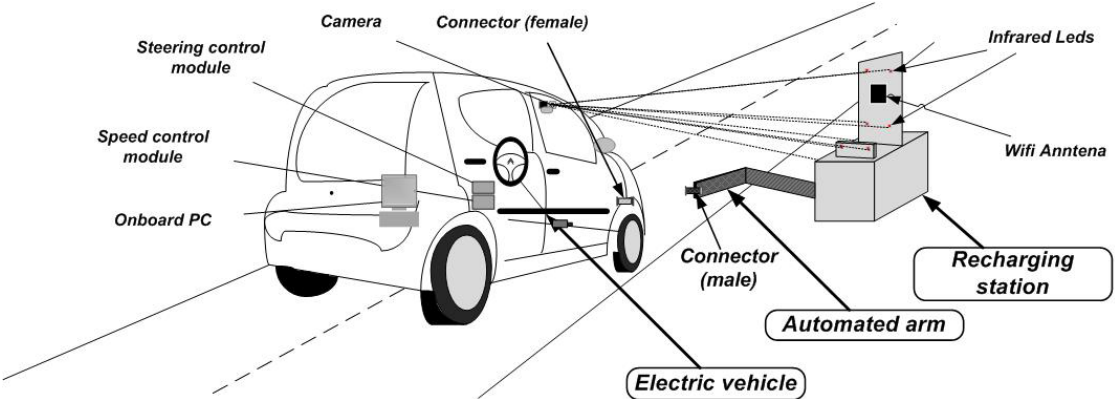
Figure 1. Elements of the system and docking maneuver of the AMARE